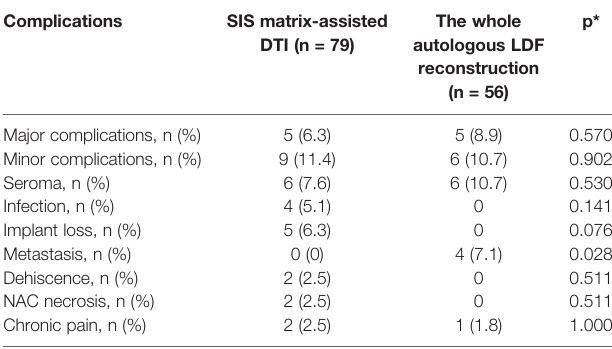
TABLE 6 | Univariate analysis results of the complications between DTI and autologous LDF breast reconstruction. Complications SIS matrix-assisted